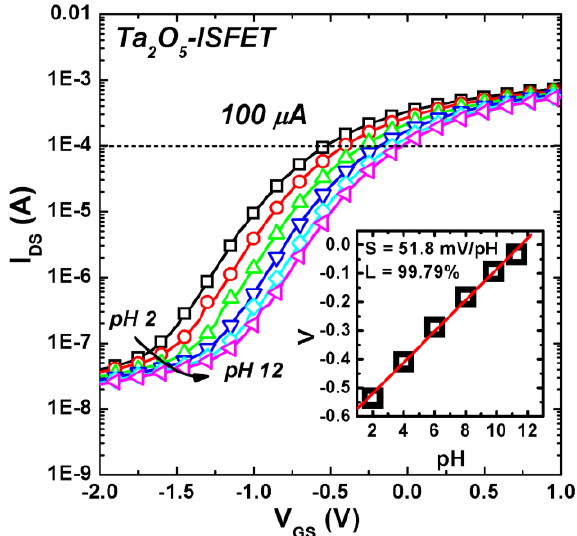
Figure 3. I –V curves of Ta DS GS pH value (from pH 2 to pH 12).